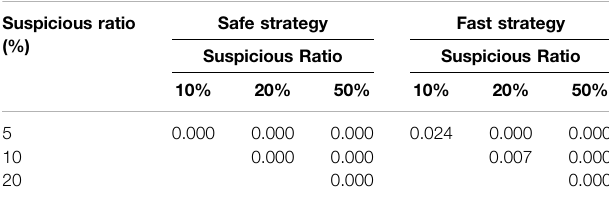
Suspicious ratio